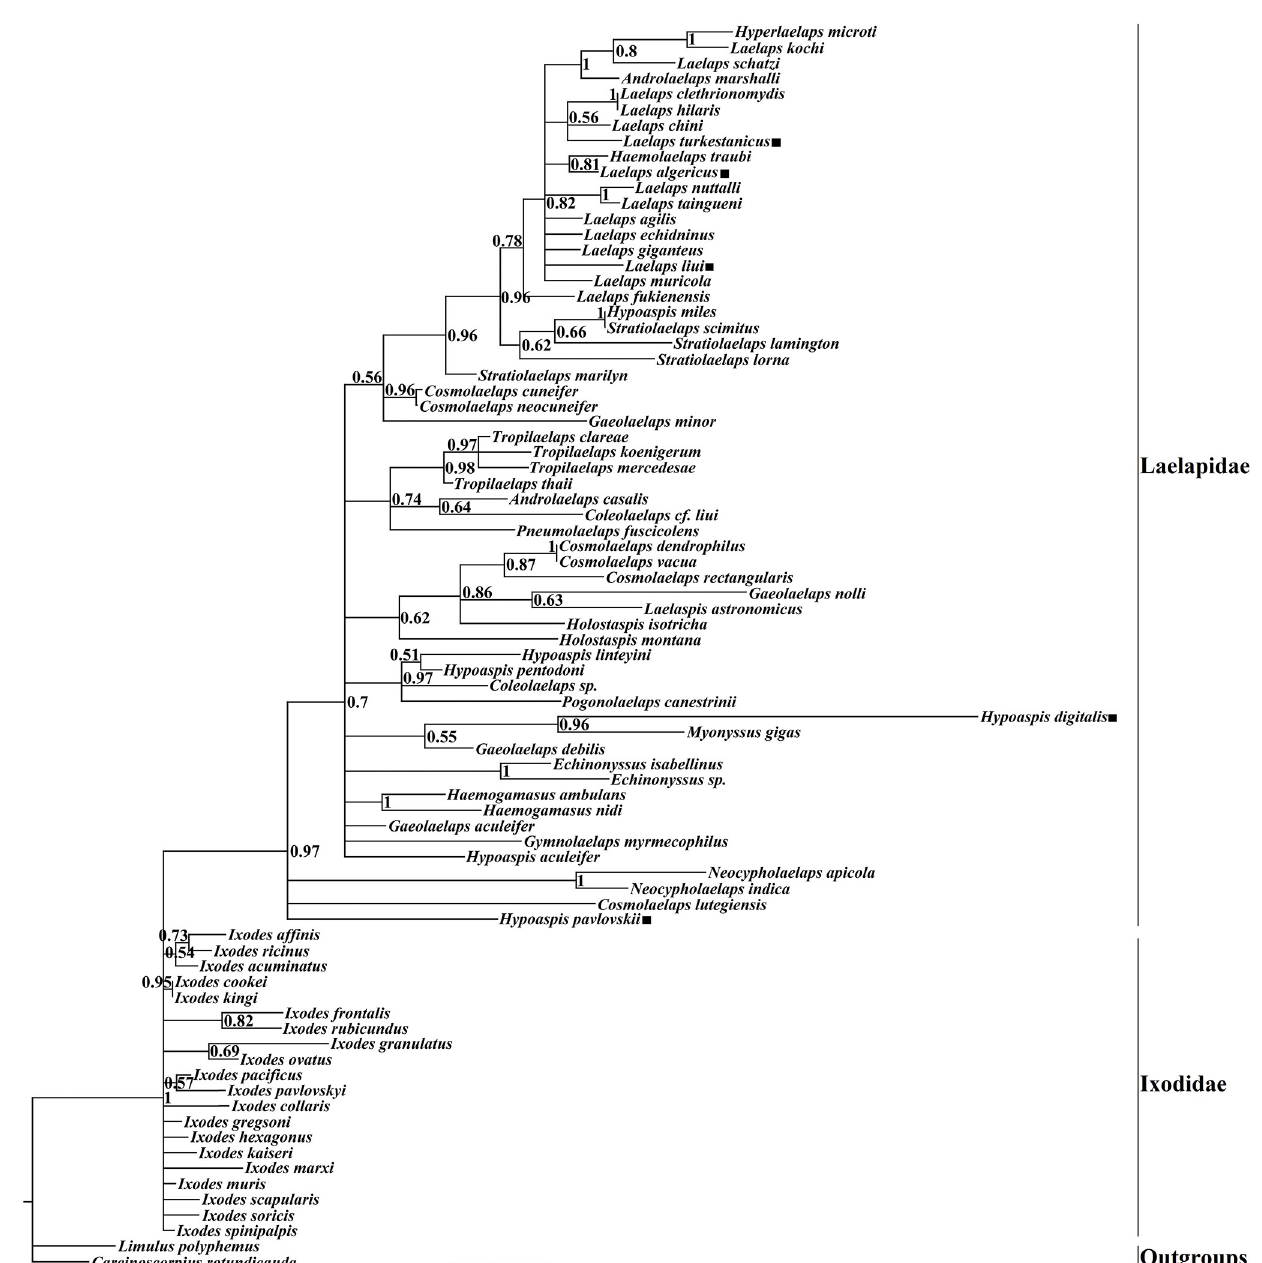
Fig 2. Bayesian phylogenetic tree constructed based on the cox1 gene sequence. The number on each node indicates the posterior probability (PP) and & indicates the species in this study.